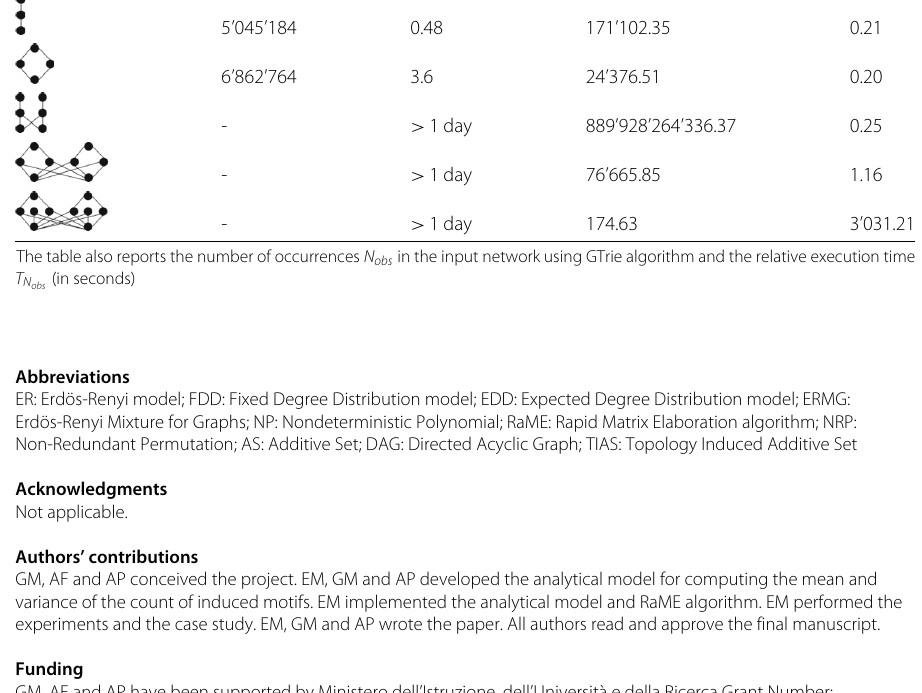
Table 7 Induced means E [ N I ( m ) ] according to the EDD model and running times T E [ N (in I ( m ) ] seconds) for the five motif graphs of Fig. 13 using RaME Topology N obs T N E [ N I ( m ) ] T E [ N obs I ( m ) ] 5’045’184 0.48 171’102.35